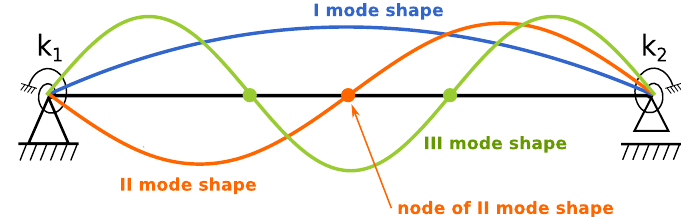
Figure 2. Model of the tie-rod. Restraints are elastic springs of unknown stiffness k 1,2 . Approximations of the first three mode shapes are shown with the respective